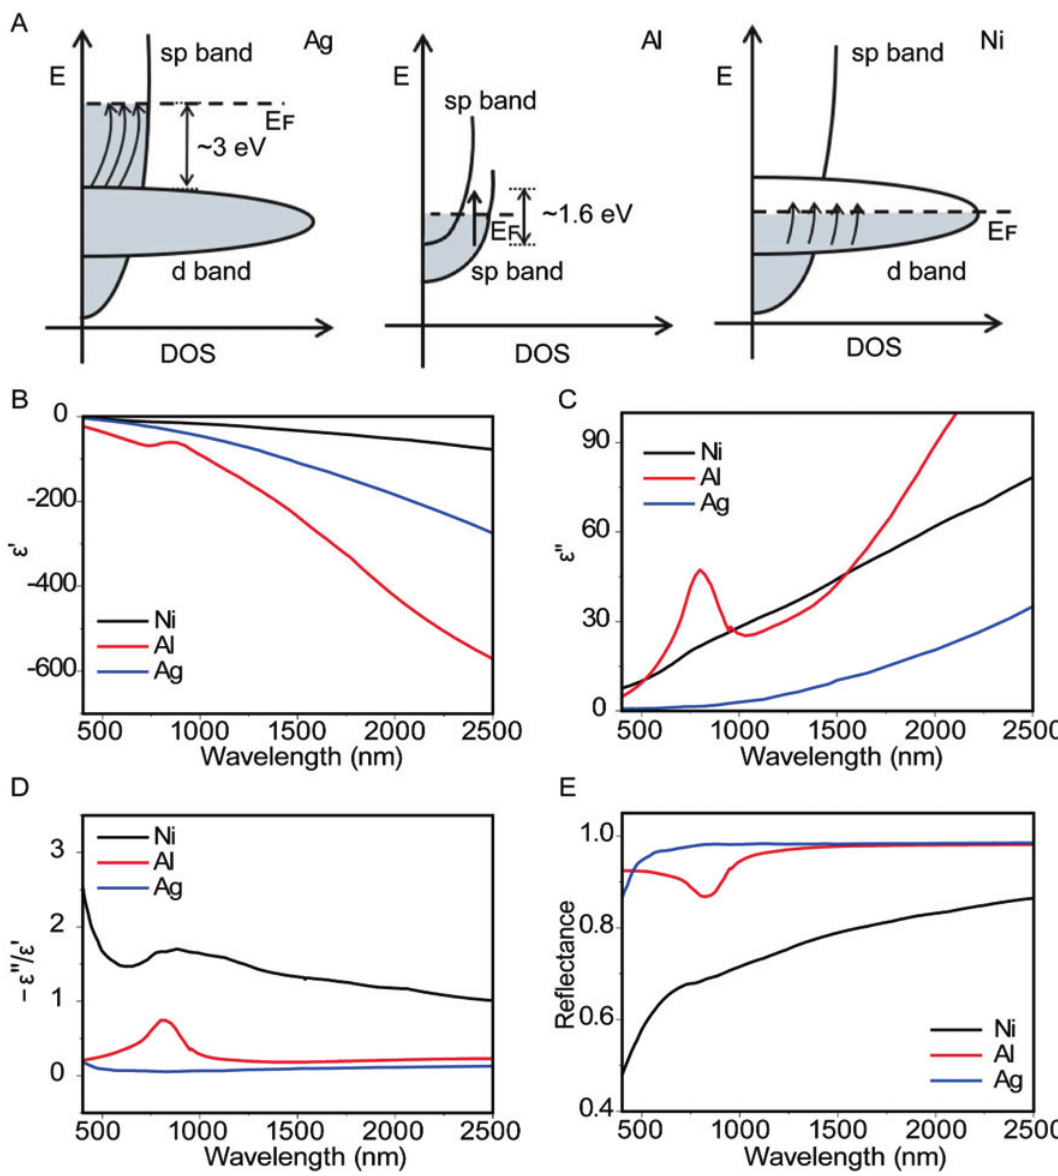
Figure2: (A) Schematicdiagramofbandstructures ofAg,AlandNi,respectively.(B,C)Dielectricfunctionsasafunctionofwavelengthforthe threemetals.(D) Calculated figureof merit ε ″ / ε ′ and (E)Zeroorder re fl ectance frommetal/airinterface as a functionof light wavelength forthe three